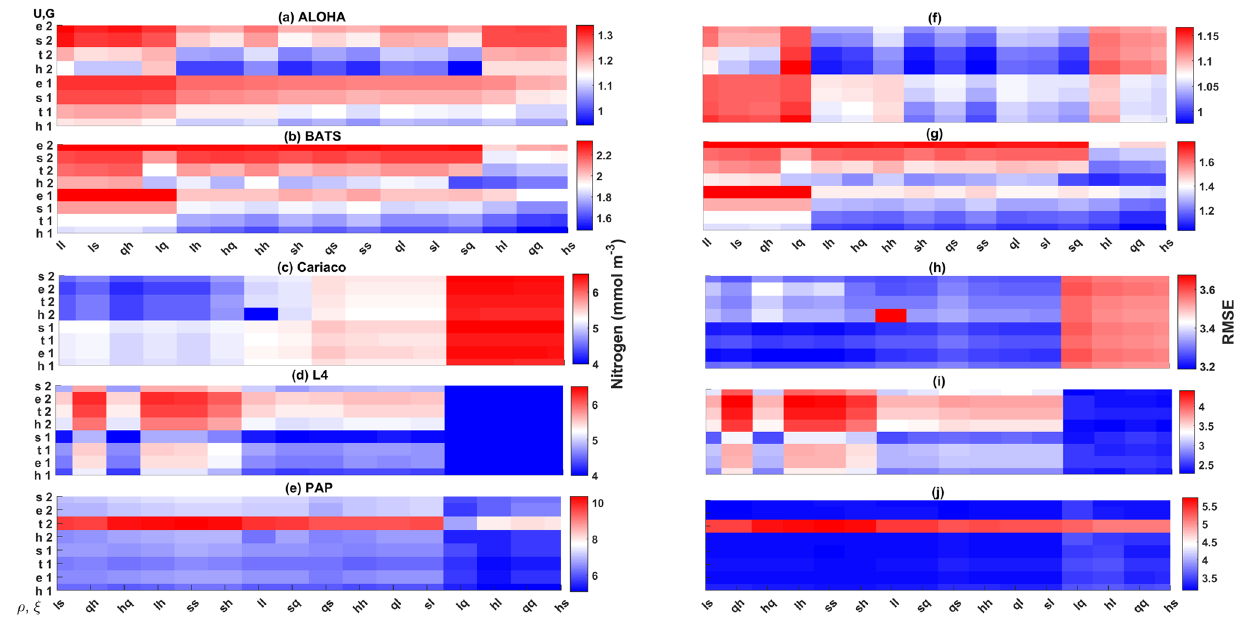
Figure 13. The 10-year mean and RMSE of DIN (mmolm − 3 ), at five stations from all ensemble members. The first column (panels a–e ) shows the DIN mean and RMSEs are shown in the second column (panels f–j ). Concentrations and RMSEs are arranged from the lowest DIN mean to the highest, depending on the oceanographic regions. For station PAP, the sequence is sorted based on coastal station. The y axis shows combinations of uptake ( U h , U s , U e , and U t ) and grazing ( G 1 and G 2 ), and the x axis shows combinations of phytoplankton ( ρ ) and zooplankton ( ξ )